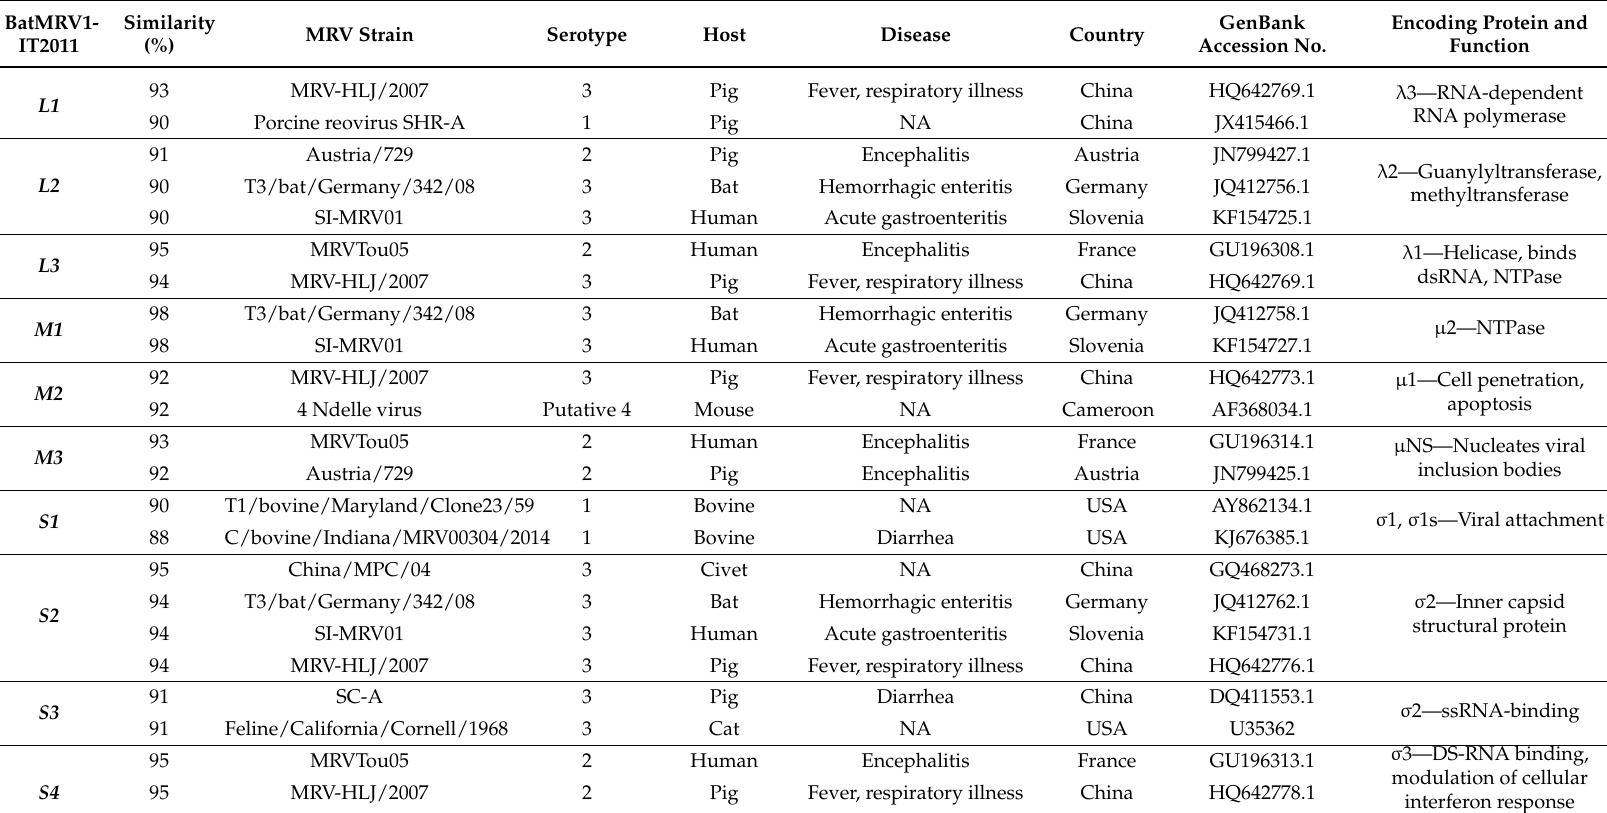
Table 1. Highest nucleotide identities for each gene segment of the novel BatMRV1-IT2011. MRV, mammalian orthoreovirus. BatMRV1-